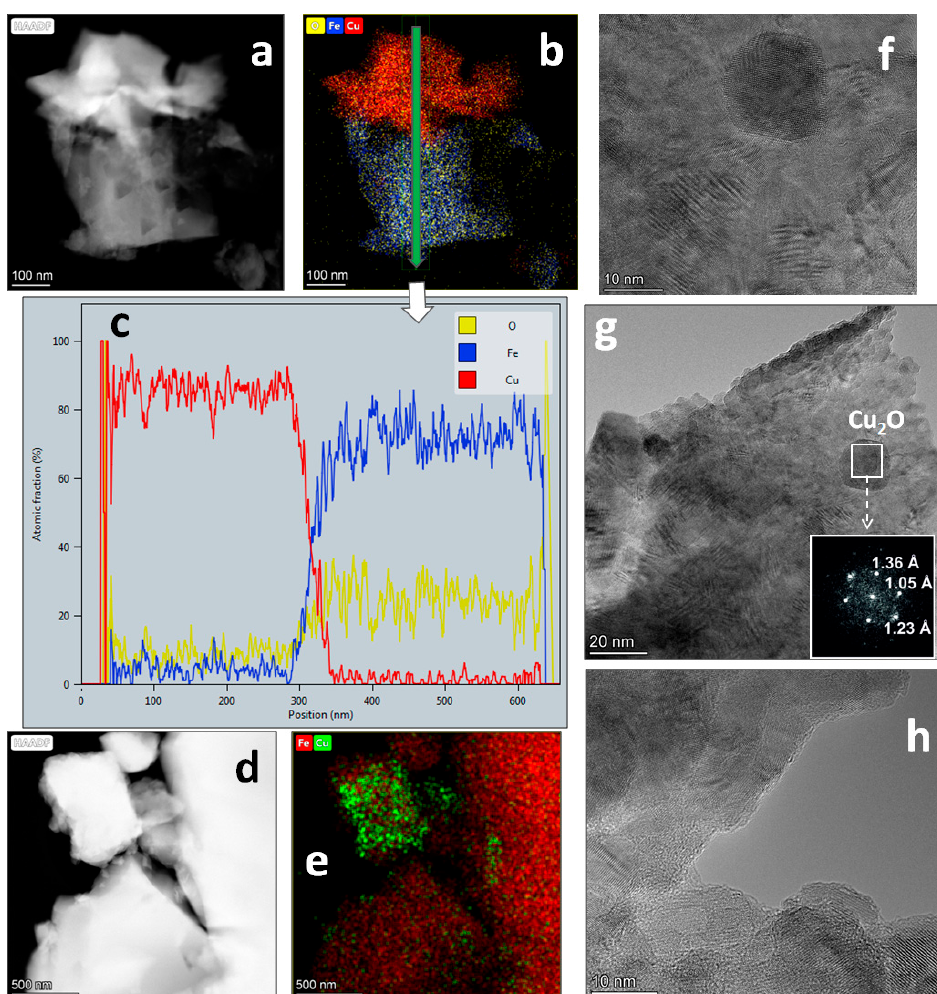
Figure 8. For an inactive CuFe-5 sample before catalytic experiments, ( a , d ) dark-field images with ( b , e ) the corresponding elemental mappings, ( c ) concentrations distribution at a particle scanning shown at ( b ), ( f–h ) HRTEM images, and (g) the selected area and its diffraction pattern.